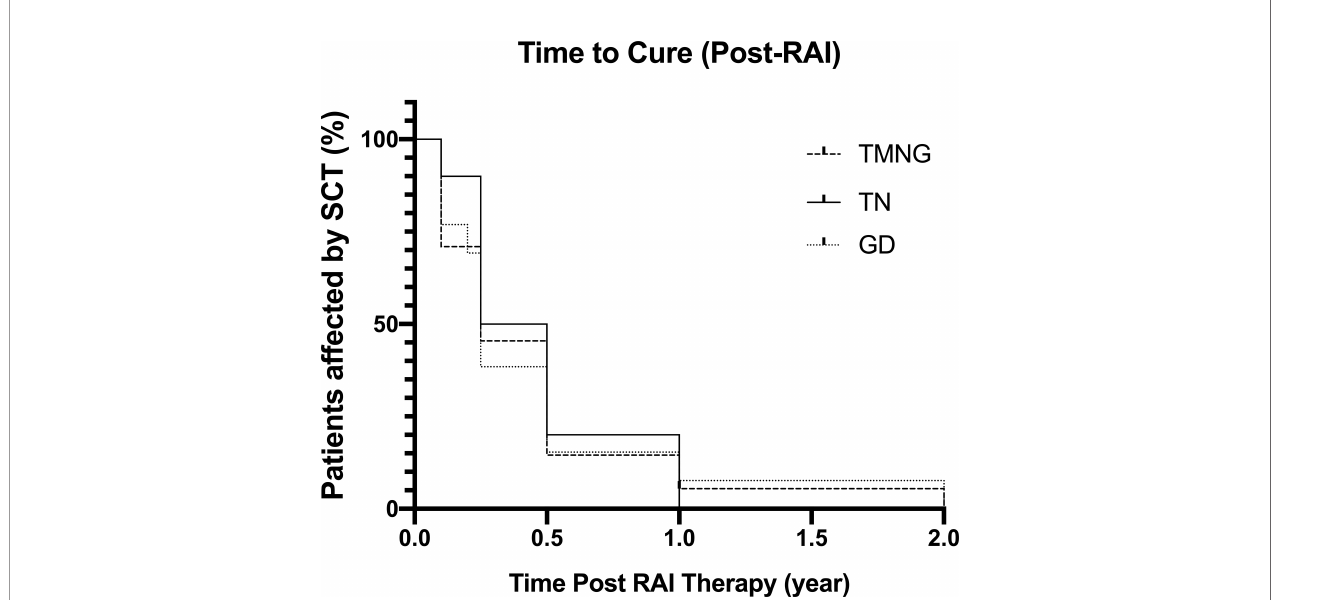
FIGURE 1 | Kaplan-Meier Graph showing time taken post-RAI to reach euthyroid or hypothyroid status, de fi ned as